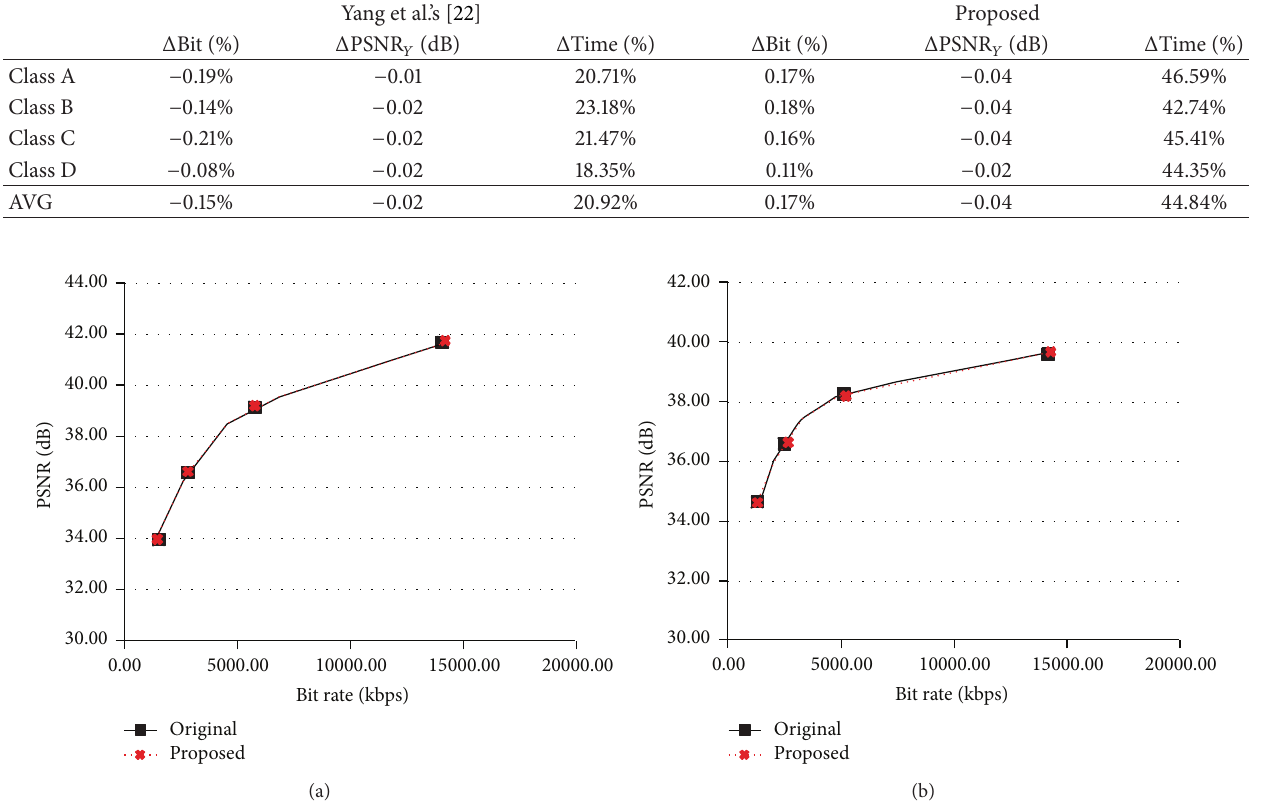
Table 4: The performance comparison with Yang et al.’s method [22] on HM reference software 10.0.